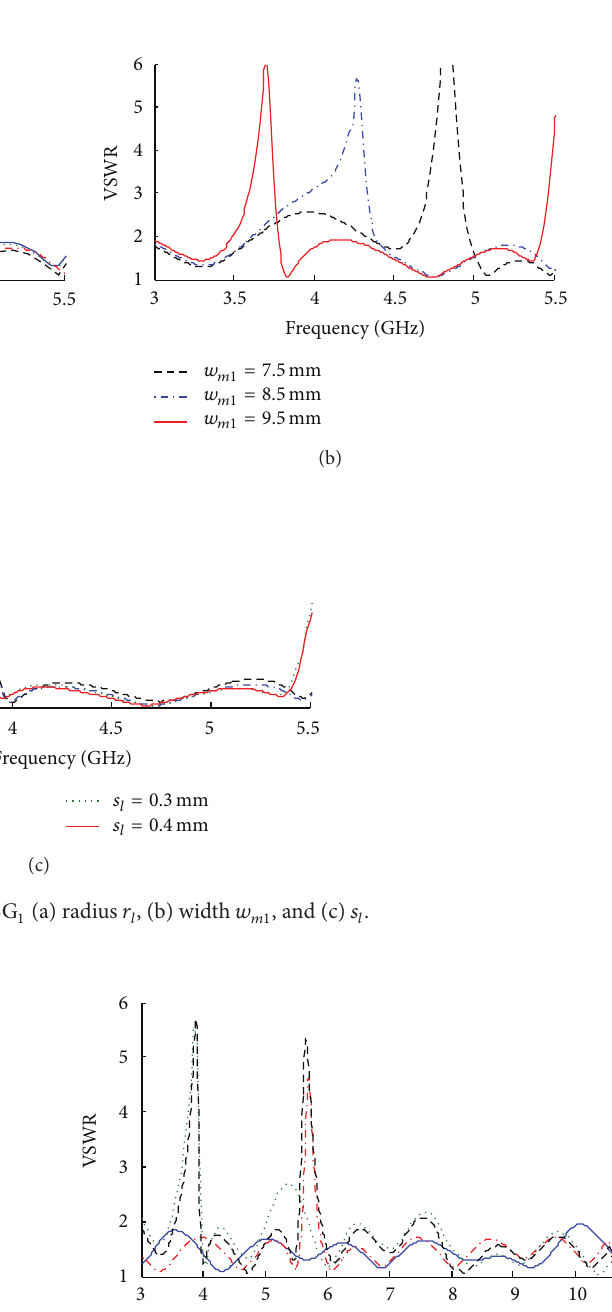
and less than 2 elsewhere. Hence, the easiness of controlling each notch without affecting the other is achieved owing to the low cross coupling between the incorporated EBG elements. Although AVA flares have a bulky size, EBG cells with electrically small dimensions are more than enough to introduce high 𝑄 reject